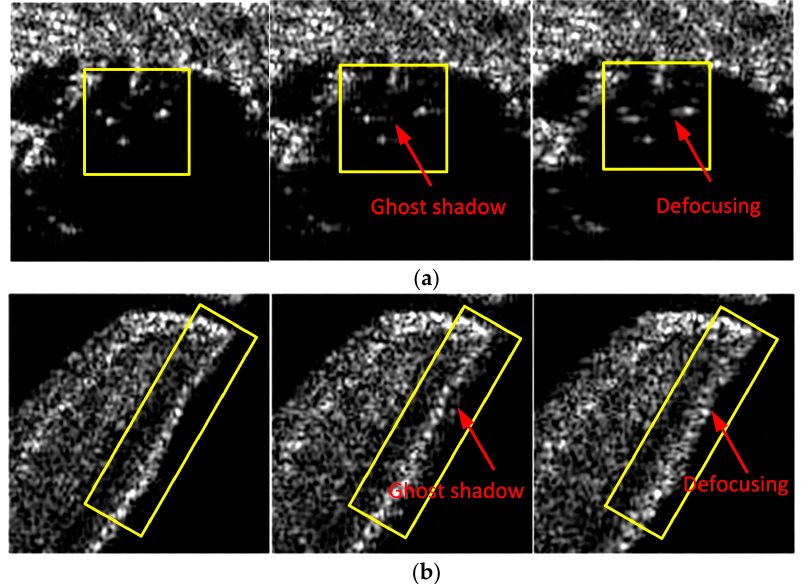
Figure 8. Comparison of three algorithms in Scene 1 and Scene 2: ( a ) Comparison of Scene 1 (left to right: FDFBPA, PTA and Two-step MOCO); ( b ) Comparison of Scene 2 (left to right: FDFBPA, PTA and Two-step MOCO).